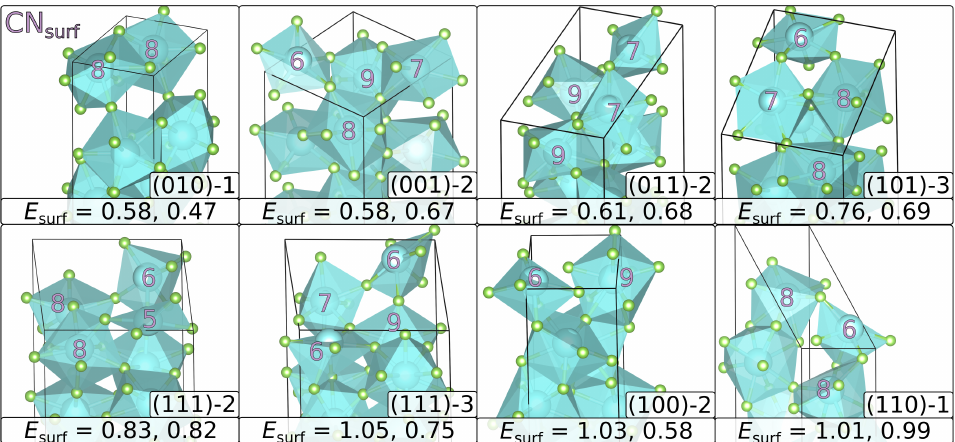
Figure 2. Relaxed, most stable surface structures: the coordination number of the surface metals (CN surf ) and the surface energies in Jm − 2 ( E surf ) are given. The first entry corresponds to YF 3 , the second to HoF 3 . The mean of both values corresponds to the given order from top left to bottom right. Each ( hkl ) slab is rotated in a way to show the surface coordination best. For (111), two surfaces are given, as (111)-2 is preferred by YF 3 and (111)-3 by HoF 3